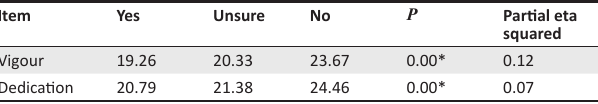
TABLE 6: ANOVA – Differences in work engagement levels based on depression